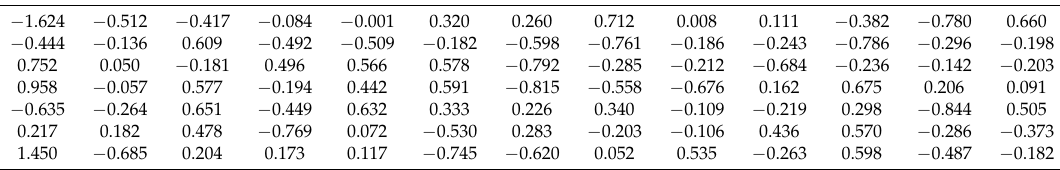
Table 5. The input weight values of the BPNN.